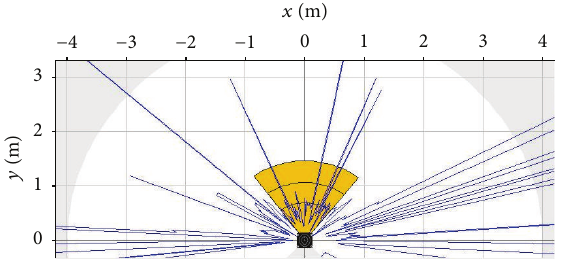
Figure 15: View of beginning to wheat mowing process.